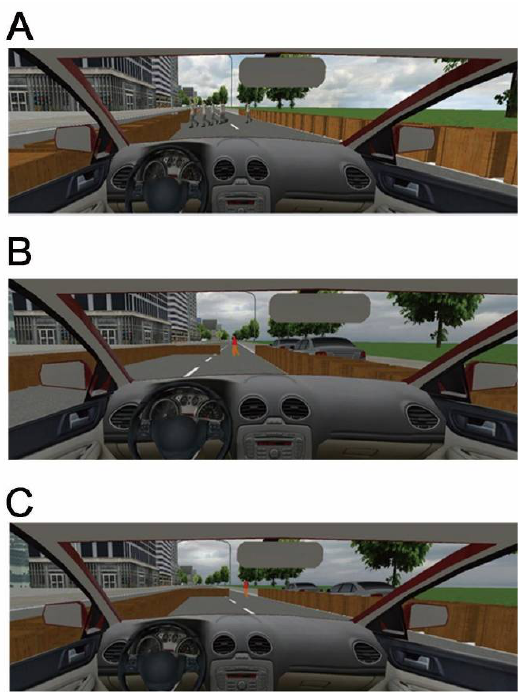
Figure 1. Three traffic situations in the simulator. The participant could decide to ( A ) hit several pedestrians or swerve to hit one pedestrian, ( B ) hit the pedestrian or swerve to hit the barrier, and ( C ) hit the barrier or swerve to hit the pedestrian. ( C ) hit the barrier or swerve to hit the